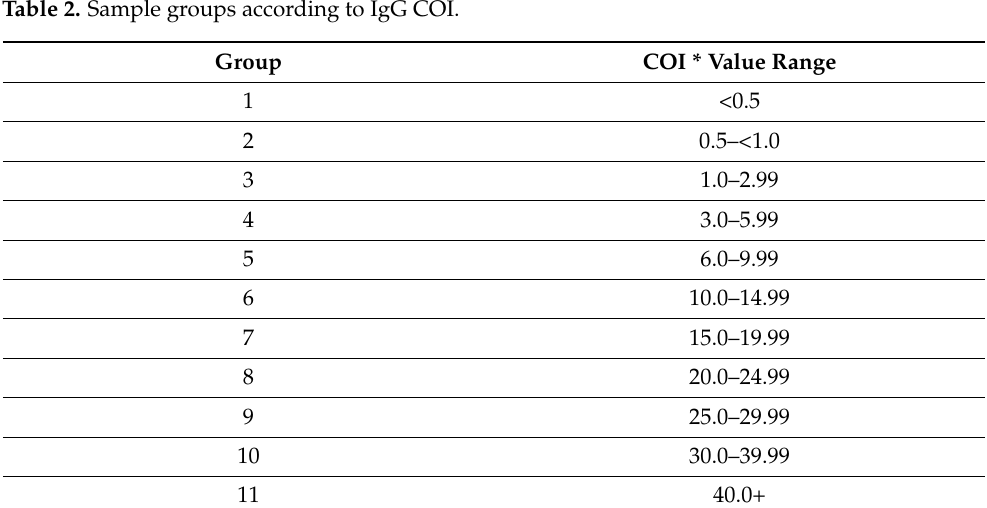
Table 2. Sample groups according to IgG